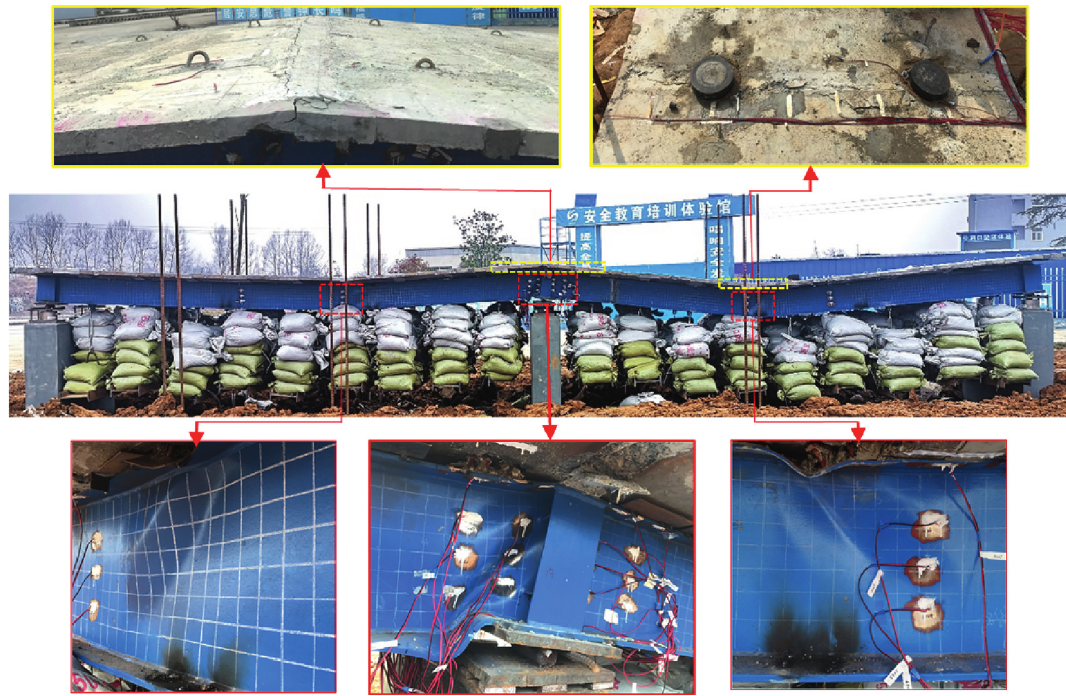
Figure 6: Failure mode of the model under the ultimate state (view of the internal girder).